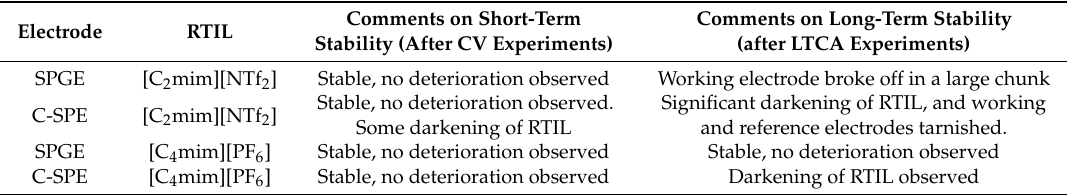
Figure 6. Photographs of the electrodes before and after being subjected to long-term oxygen sensing experiments using LTCA: ( a ) unused SPGE, ( b ) unused DropSens C-SPE, ( c ) SPGE with [C 2 mim][NTf 2 ], ( d ) DropSens C-SPE with [C 2 mim][NTf 2 ], ( e ) SPGE with [C 4 mim][PF 6 ], and ( f ) DropSens C-SPE with [C 4 mim][PF 6 ]. Scale bars indicate the diameter of the working electrode. Table 2. Overview of physical observations of the SPGEs and C-SPEs following short-term cyclic voltammetry experiments, and harsher long-term chronoamperometry experiments. Electrode